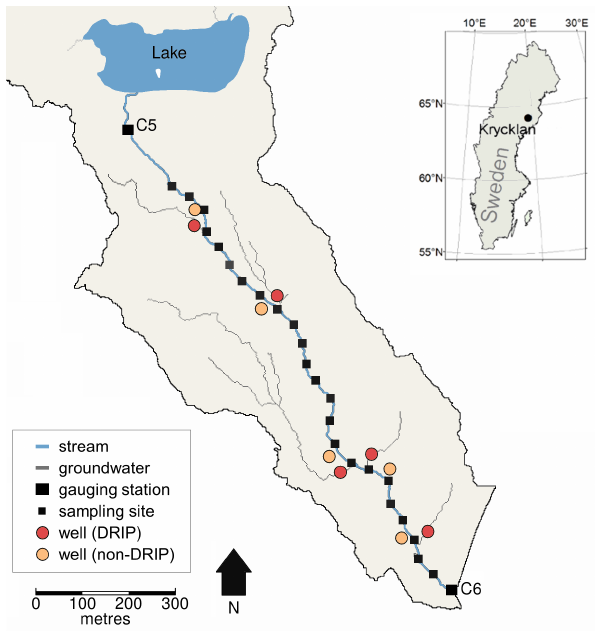
Figure 1. The Stortjärnsbacken catchment in Krycklan, Sweden. The stream reach (blue line) starts at the outlet of Lake Stortjärn (gauging station C5) and ends at the downstream gauging sta- tion C6. Stream sampling sites at approximately 50m increments are indicated with small black squares. Groundwater wells along the reach are indicated with red circles (DRIPs) and orange cir- cles (non-DRIPs). At DRIPs, groundwater flow paths (grey lines) converge in the riparian zone.